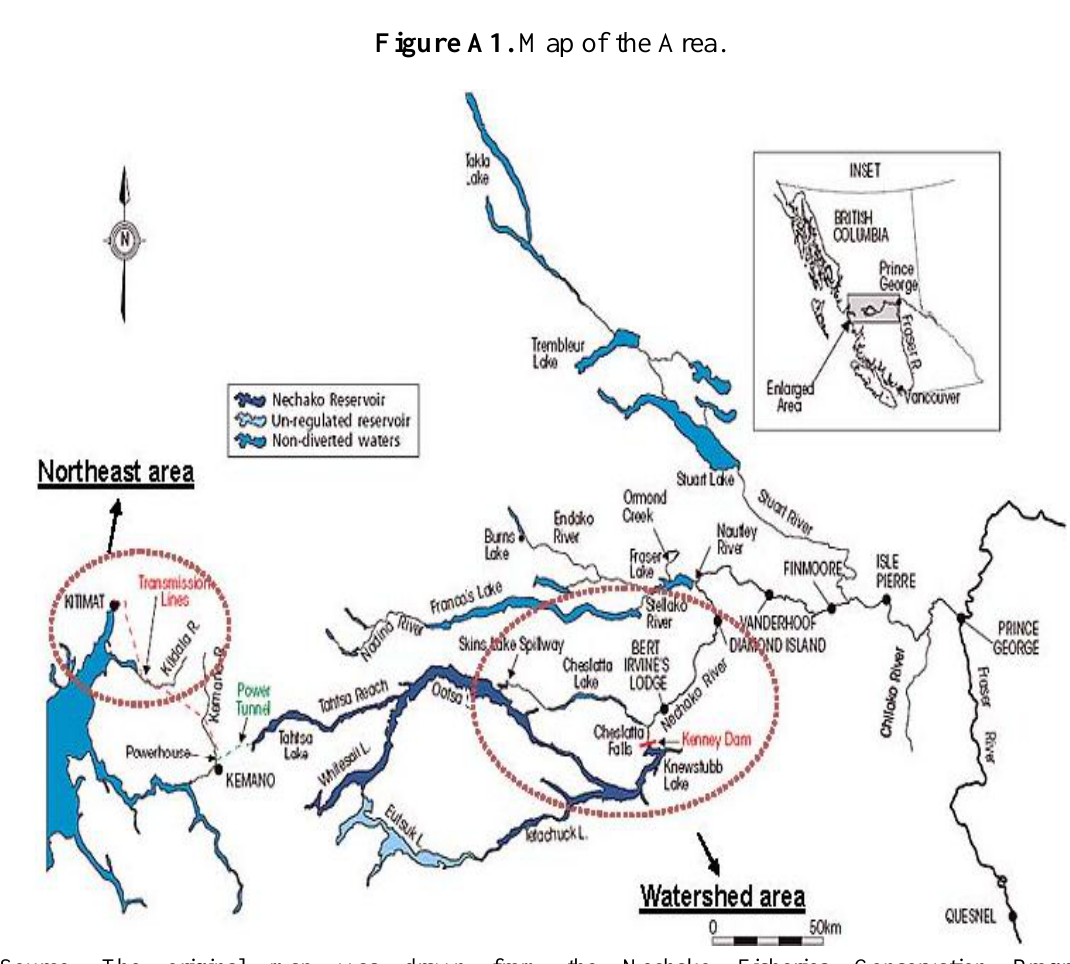
Figure A1. Map of the